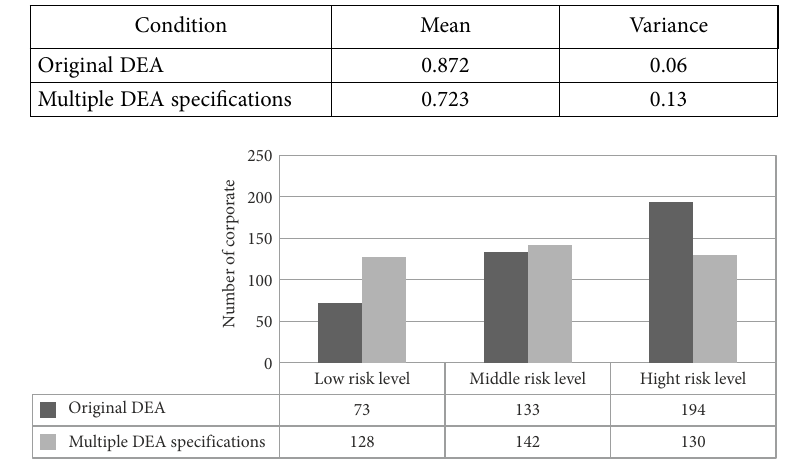
Figure 7. The discriminant ability of two assessment measures